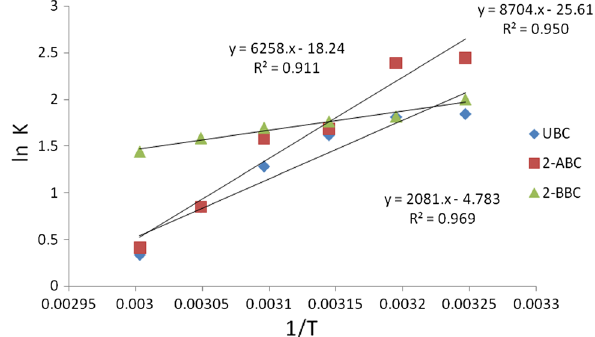
Fig. 7 Kinetic models fit of adsorption of atrazine molecule with the UBC, 2-ABC and 2-BBC. a Pseudo-first; b pseudo-second; c intra- particle; d Elovich